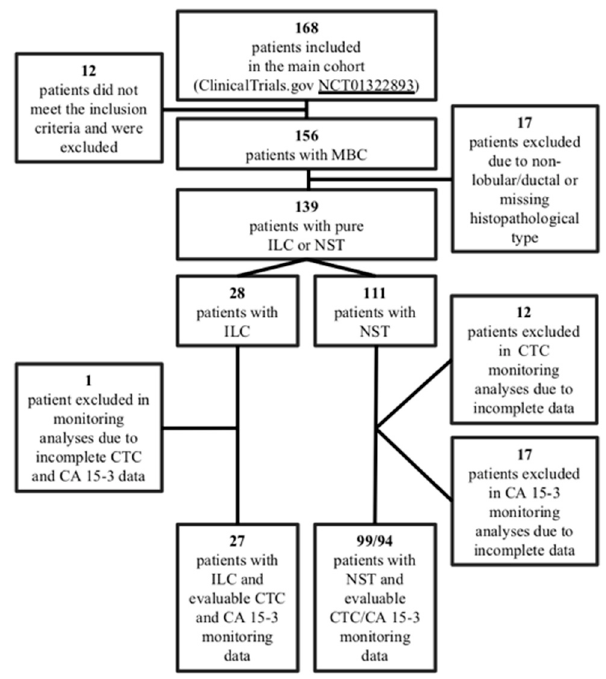
Figure 1. Flowchart of the study cohort.